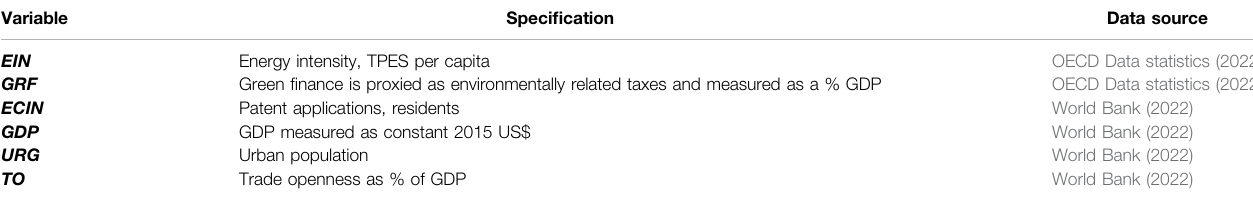
TABLE 1 | Variable speci fi cation and data sources. Variable